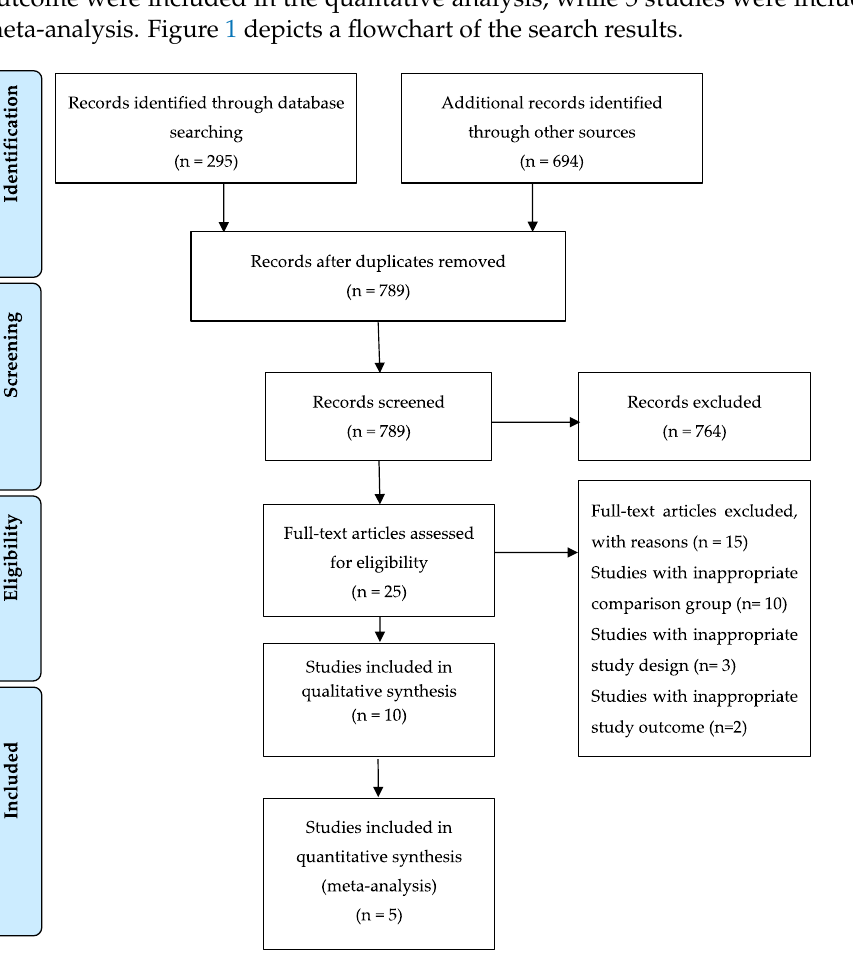
Figure 1. PRISMA flow diagram.